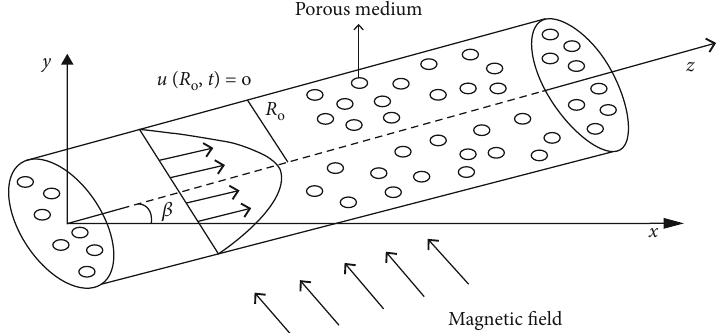
Figure 1: Schematic diagram of the fl ow